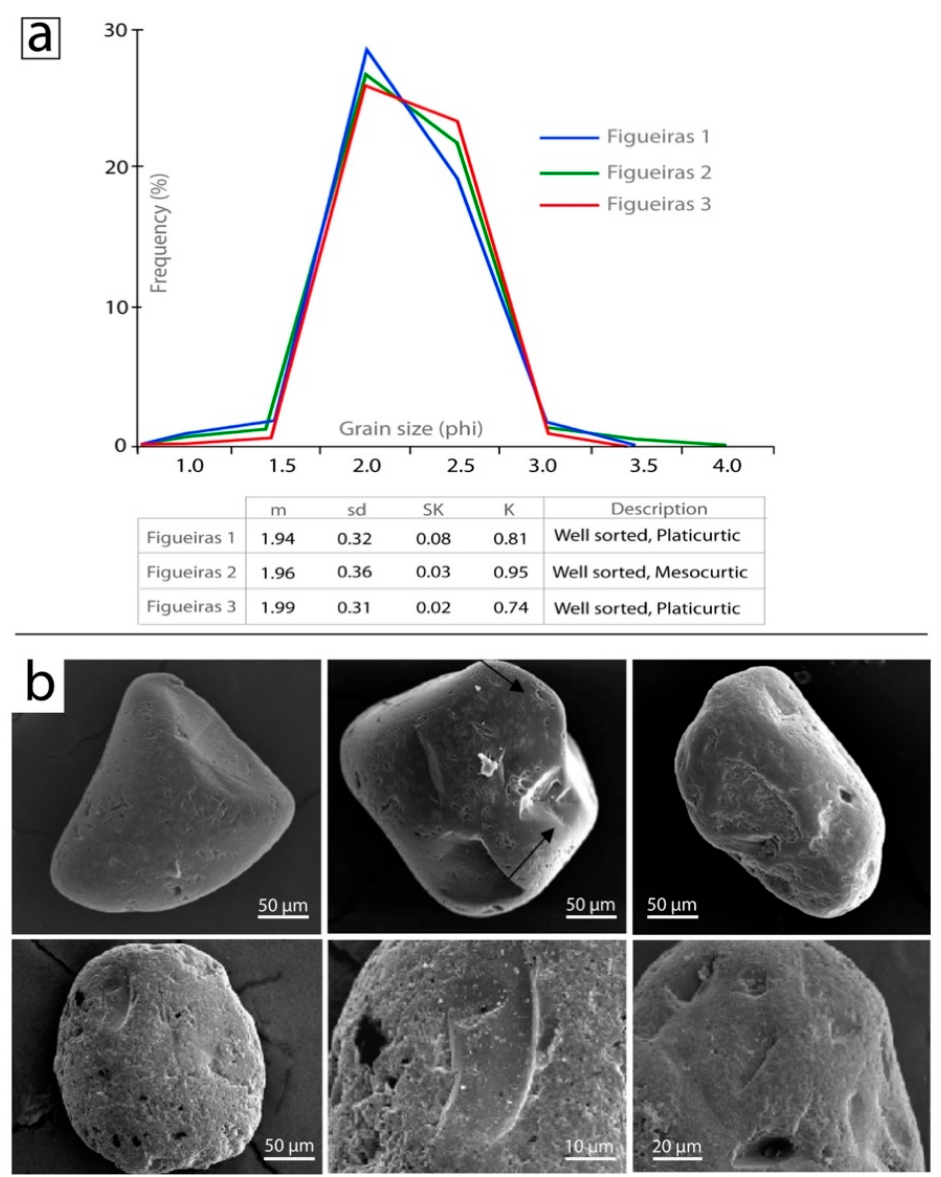
Figure 5. ( a ) Dry-sieving particle size and distribution of the samples from Figueiras aeolianite (Cies Islands): (m) mean, (sd) standard deviation, (SK) skewness coefficient, (K) kurtosis from the method described in [55]. ( b ) Scanning Electron Microscope (SEM) images of quartz grains showing aeolian impact marks.